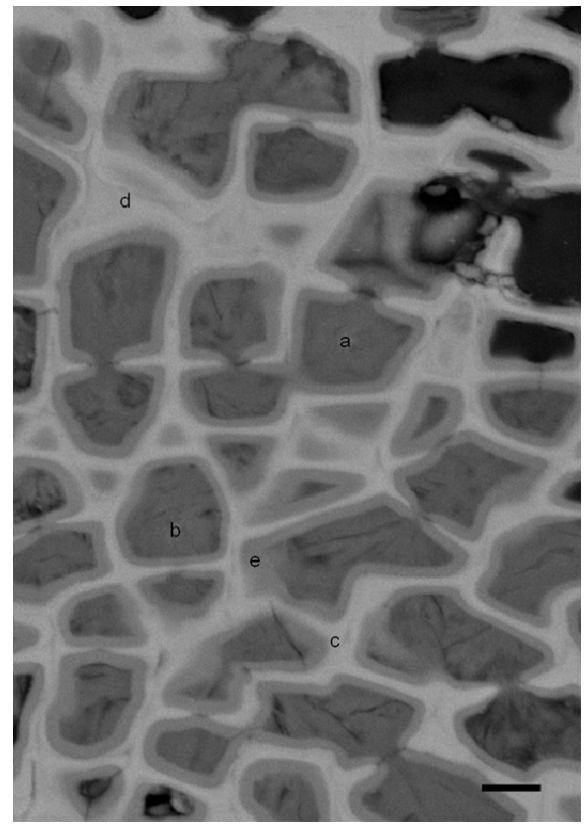
Fig. 1. SEM backscattered electron (BSE) image of coralline alga (sample 302) showing detail of magnesite cell infill (a) , (b) and protodolomite rims (e) within Mg-calcite cell wall structure (d) . Black lines and textures within the cells are most likely voids or remnant organic structures. Above ( d) micron scale bands of slightly darker grey within the cell walls indicate varying magne- sium within the cell wall. Concentric zonation is seen around cells (top left). SEM-EDS spot analyses of labeled sites (a) = 99.22, (b) = 99.19, (c) = 23.9, (d) = 15.17, (e) = 45.75mol% MgCO 3 . Scale bar =